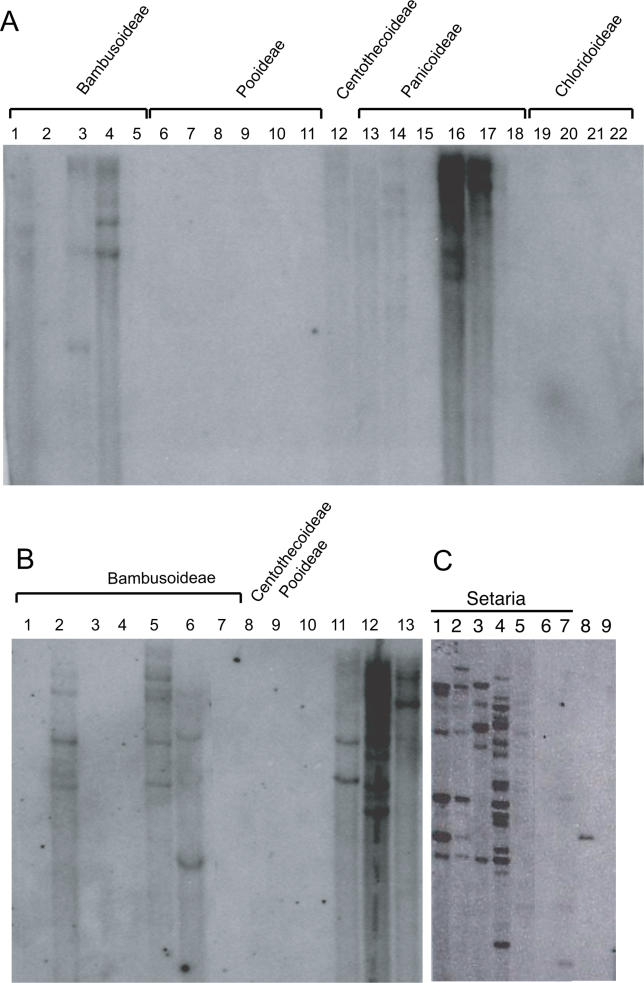
DNA Gel Blots of Representative Species from All Major Subfamilies of the GrassesAll blots were probed with a fragment of MULE sf3 from S. faberi. Subfamilies (i.e., Pooideae) are as indicated.(A) 1, Shibataea kumasaca; 2, Ehrharta erecta; 3, Oryza sativa indica; 4, Oryza sativa japonica; 5, Zizania latifolia; 6, Nardus stricta; 7, Diarrhena japonica; 8, Brachypodium sylvaticum; 9, Phalaris aquatica; 10, Hordeum vulgare; 11, Triticum aestivum; 12, Chasmanthium latifolium; 13, Andropogon gerardii; 14, Sorghum bicolor; 15, Tripsacum dactyloides; 16, S. faberi; 17, S. italica; 18, Zea mays; 19, Muhlenbergia rigens; 20, Eleusine indica; 21, Boutelova curtipendula; 22, Cortaderia jubata.
(B) 1. Zizania latifolia; 2, Shibataea kumasaca; 3, Chusquea montana; 4, Chusquea quila; 5, Sinarundinaria nitida; 6, Phyllostachys vivax; 7, Otatea acuminata; 8, Zeigotes sp.; 9, Brachypodium sylvaticum; 10, Zizania latifolium; 11, O. sativa (japonica); 12, S. faberi; 13, S. italica.
(C) 1, S. italica; 2, S. italica; 3, S. viridis; 4, S. faberi; 5, S. glauca; 6, S. anceps; 7, S. sphacelata; 8, O. sativa; 9, Zea mays.